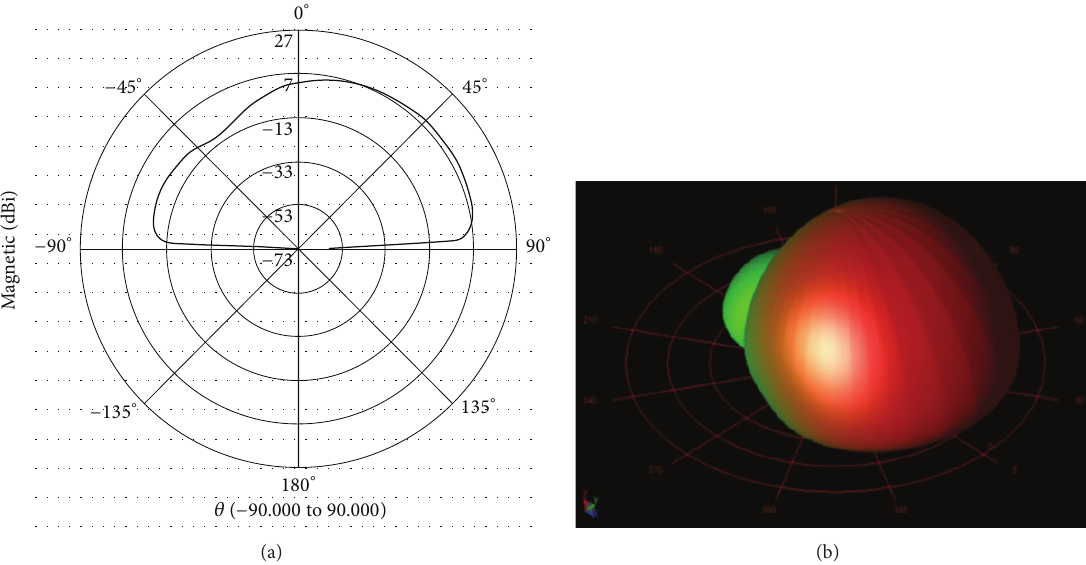
Figure 6: Simulated radiation gain patterns in elevation plane (Φ = 0 ∘ ) and at operation frequency 𝑓 = 12 GHz. (a) Two-dimensional (2D) case, (b) three-dimensional (3D) case.